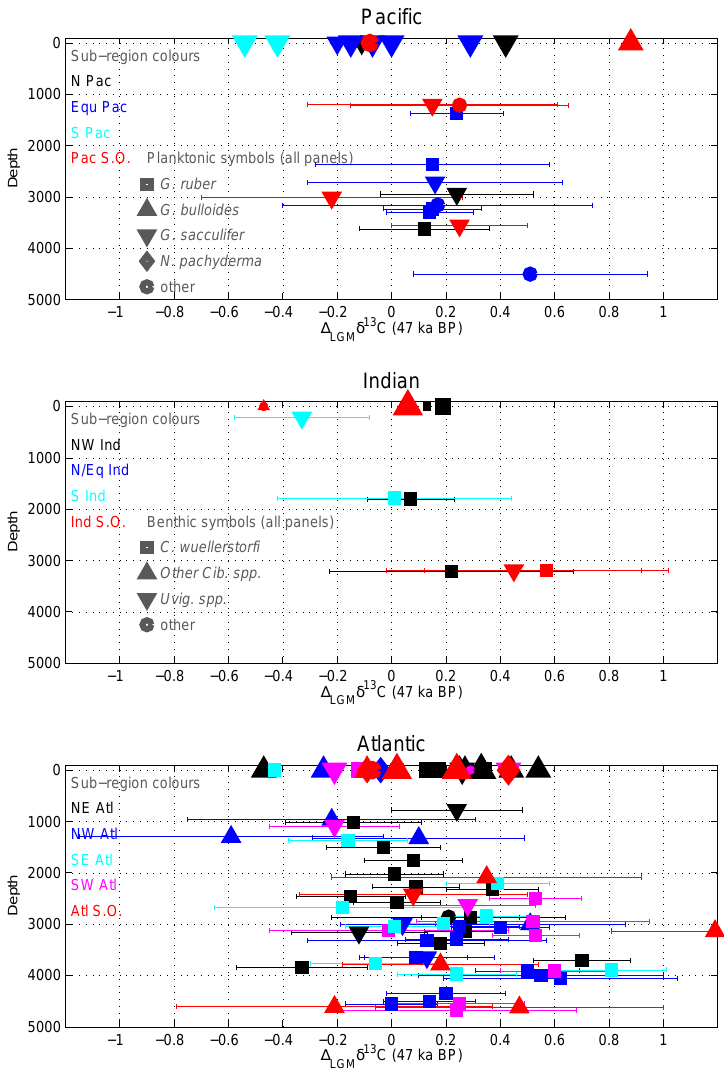
Fig. 12. 47ka 1 LGM δ 13 C time-slice, with 2 σ error bars on benthic data. region to be distinguishable from random error, the appar- ent scatter in the data would exceed that predicted by the Fig. 12. 47 ka ∆ LGM δ 13 C time-slice, with 2 σ error bars on benthic data. error bars. Since the scatter in the data in Figs. 10–14